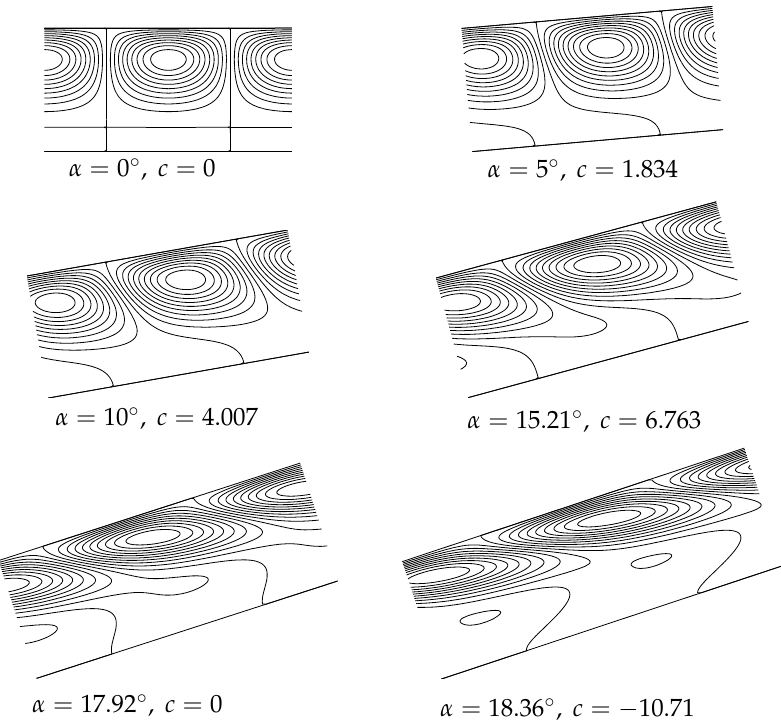
Figure 6. Showing the disturbance isotherms for one spatial period for transverse rolls when ξ = 5. The isotherms are at 20 equally-spaced intervals in each